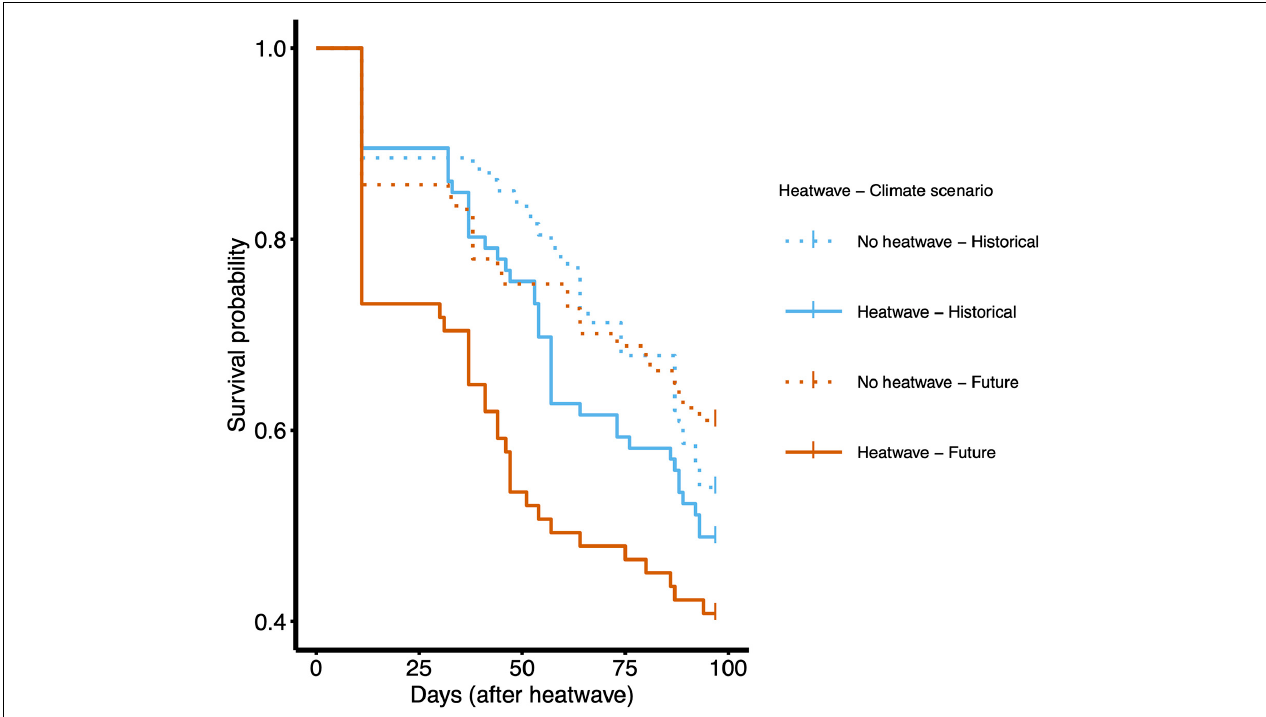
FIGURE 4 | Kaplan–Meier survival graph by longevity, analyzed as days from the end of the heatwave treatment to the end of the experiment, for the 321 plants alive at this point. The graph shows results for the interaction between factors ‘Heatwave’ and ‘Climate scenario.’ Kaplan–Meier curves were obtained using the survfit function in ‘survival’ package (random effects in Cox mixed effect model explain little of the variance, therefore results can be assumed to be comparable to a model without them). Curves were plotted using the ggsurvplot function in ‘survminer’ package. Dotted lines = no heatwave; solid lines = heatwave. Blue lines = historical climate scenario; red lines = future climate scenario. The effect of elevation was not significant and is not presented in this